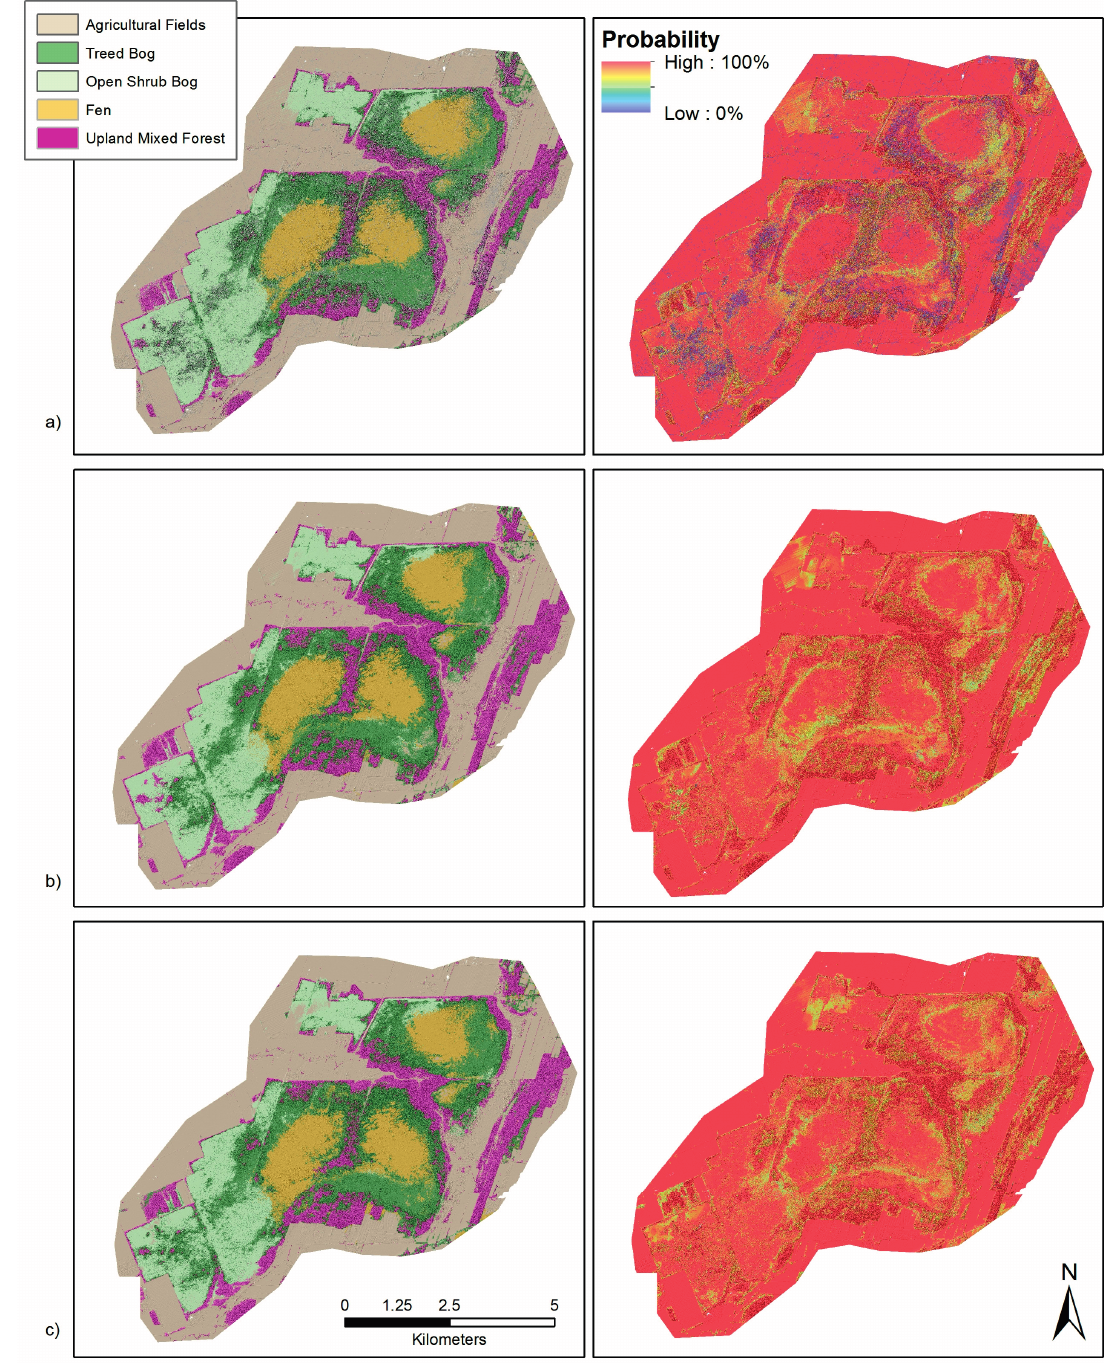
Figure 5. Comparison of classifications based on All Variables ( a ), Important Variables ( b ), and Uncorrelated Important ( c ). Maps on the left demonstrate the most frequently predicted class in 25 iterations and maps on the right indicate the number of times the most commonly predicted class was classified based on 25 iterations. In the All Variables classification , many cells demonstrate a low probability of being classified as the most commonly predicted class. In the other two classifications, most of the cells demonstrate moderate to high probability of being classified as the most commonly predicted class. Although similar, the Important Variables and Uncorrelated Important Variables classifications are statistically significantly different according to the McNemar’s